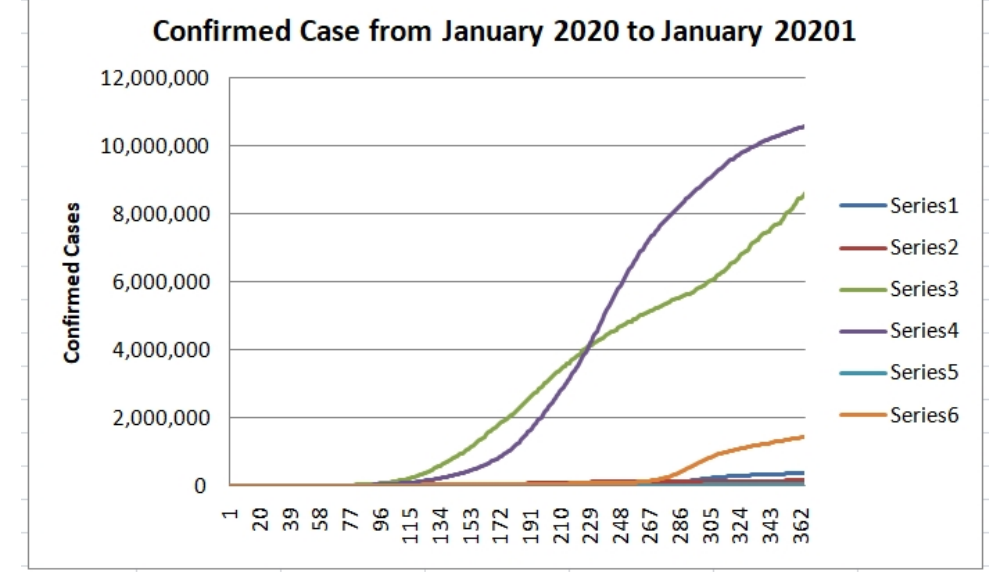
Figure 14. Time series of six countries of the 22 January 2020 to 19 January 2021.